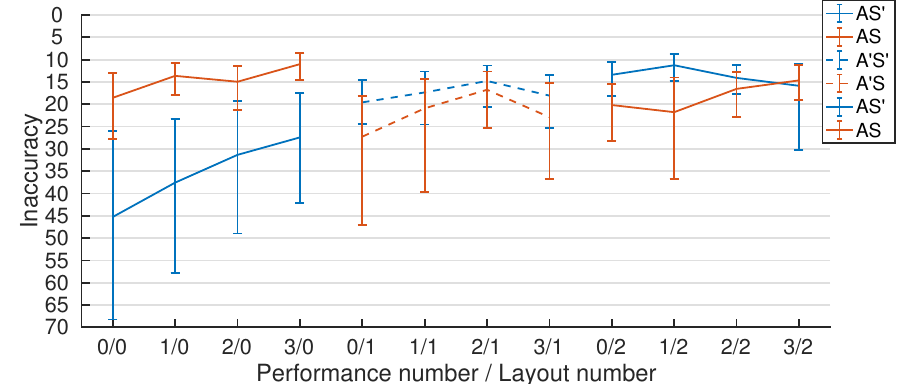
Figure 5. Inaccuracies, averaged across participants, for the transfer task ( Frère Jacques ). The higher the line, the more accurate the average performance. The bootstrapped confidence intervals cover a 95% range. Adjacent layouts have solid lines, nonadjacent have dashed lines. Sheared layouts have orange lines, unsheared have blue lines. The first performance is coded 0, the second is coded 1, ...; the first layout is coded 0, the second is coded